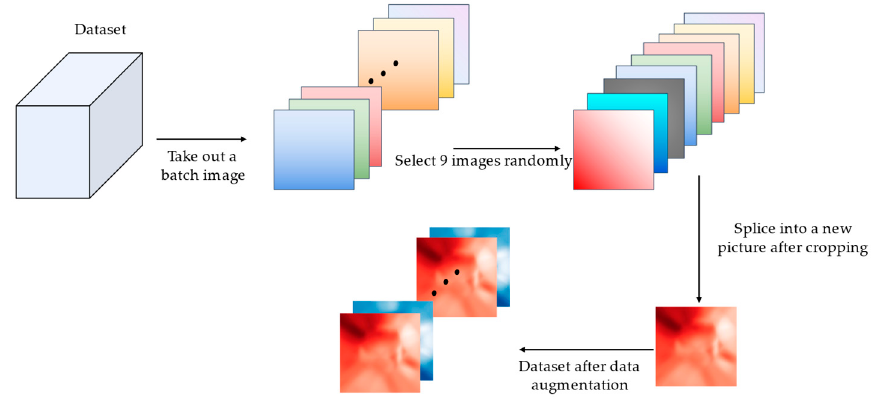
Figure 5. A flow chart of Mosaic-9 data augmentation.